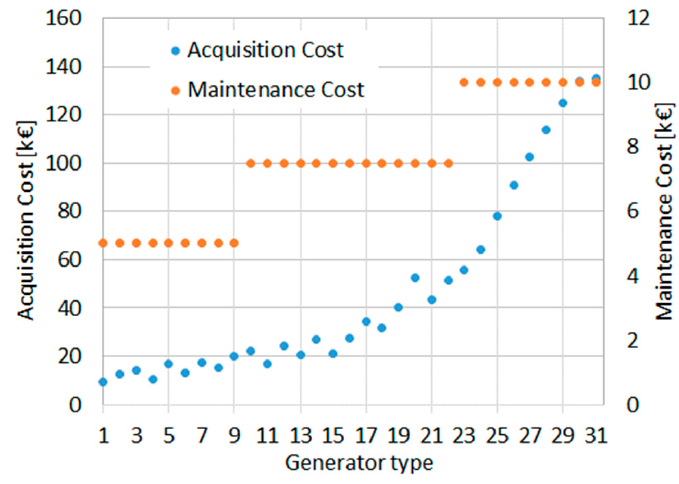
Figure 10. Acquisition cost and maintenance cost.